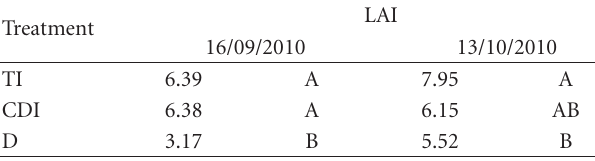
Table 6: Leaf area index (LAI) at two sampling points for total irrigation (TI), irrigation with controlled deficit (CDI), and dry (D) treatments.